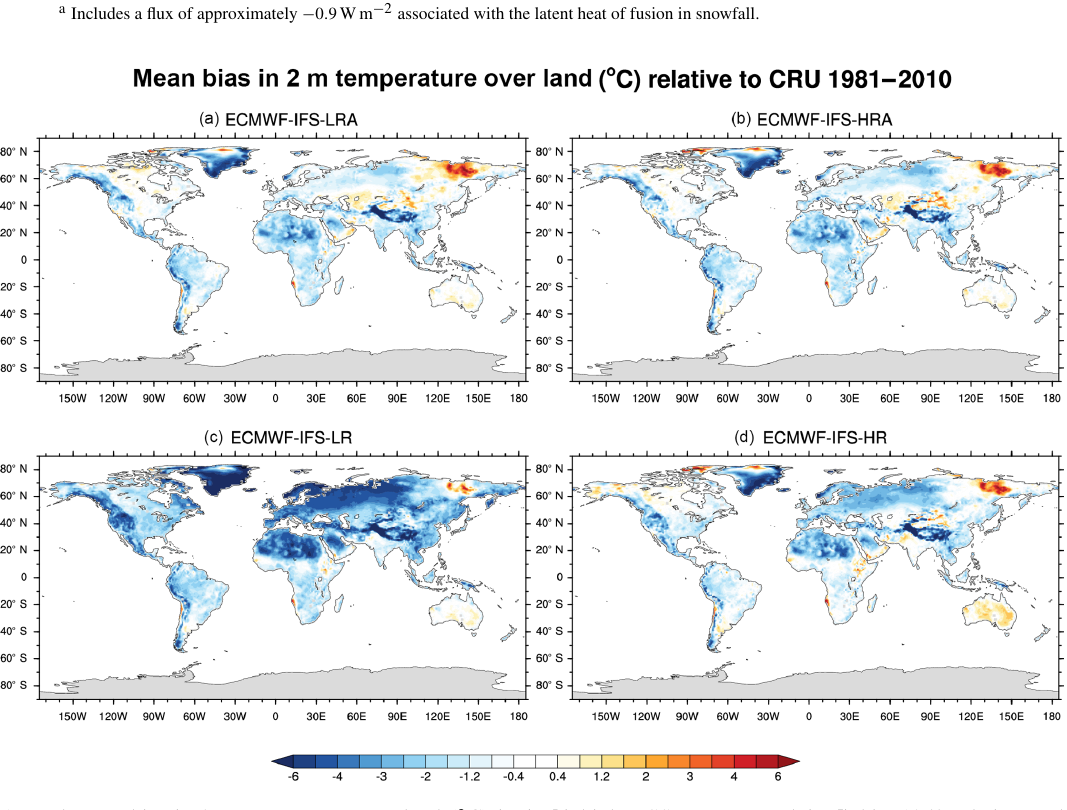
Figure 2. Annual mean bias in 2m temperature over land ( ◦ C) in (a–b) highresSST-present and (c–d) hist-1950 relative to the Climate Research Unit time series 4.01 data set (CRU TS; Harris et al., 2014) for the period